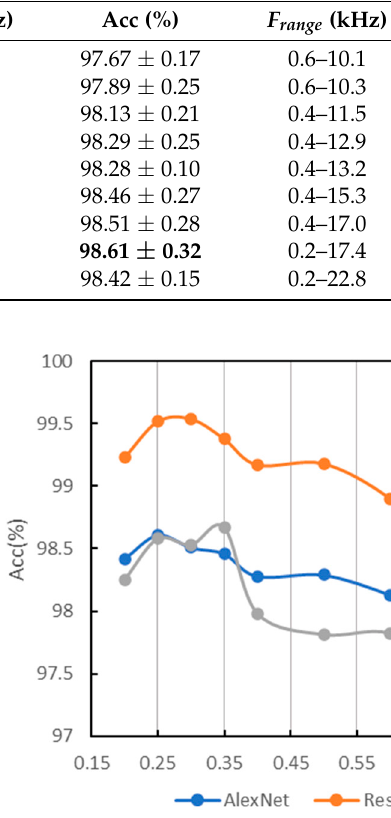
Figure 4. Results of different λ on PU.